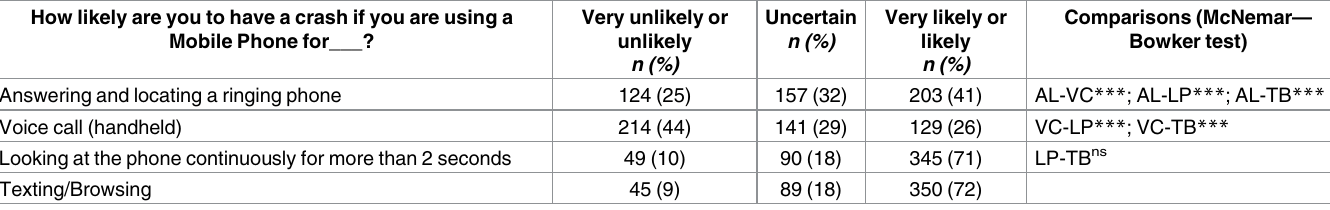
Table 3. Perceived crash risk per mobile phone